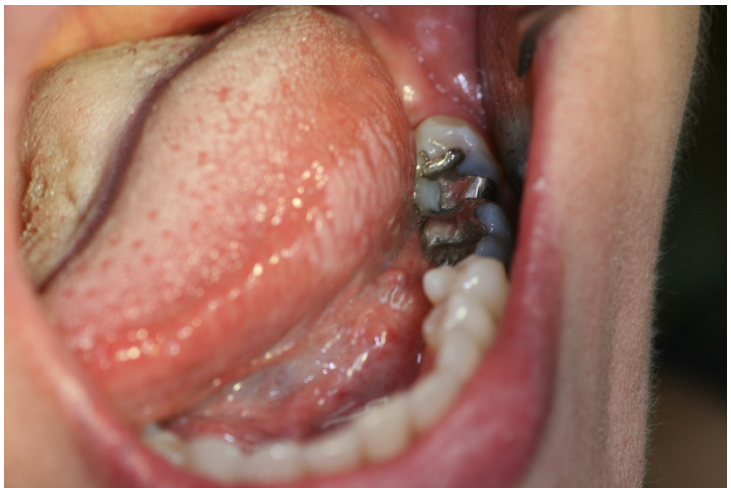
Figure 1. White corrugated lesion measuring 20 × 15 mm on the left dorsal border of the tongue. Presence of two amalgam fillings on 3.6 and 3.7 teeth.